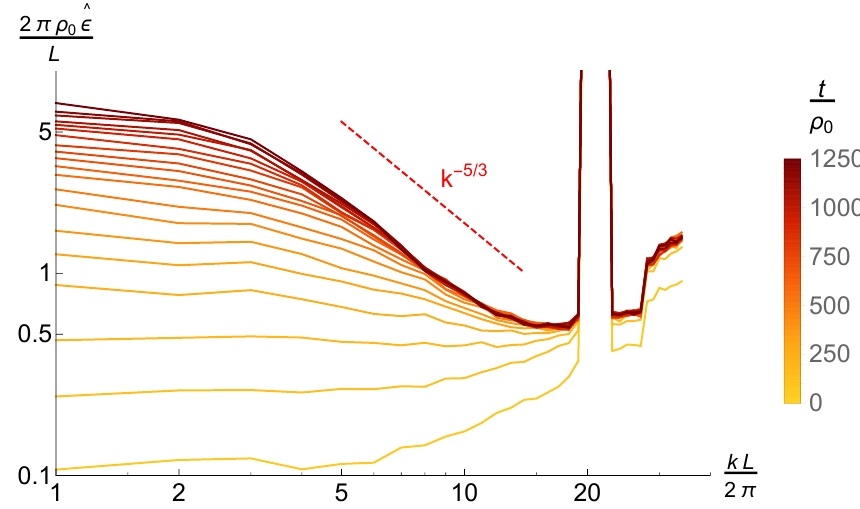
Figure 4 . The non relativistic energy power spectrum defined in (5.4) as a function of momenta for different times. The displayed data has been obtained after ensemble averaging over 36 runs. The clearly visible maximum is due to the driving force located at k f L/ 2 π = 21 , and has been clipped in order to highlight the power law behavior at low